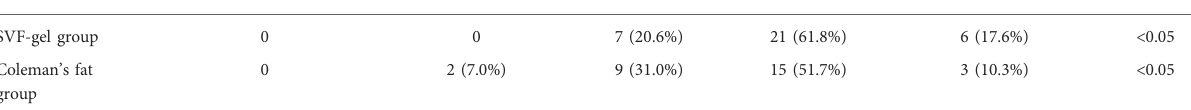
TABLE 3 Patient satisfaction rates of patients in the SVF-gel group and Coleman ’ s fat groups.